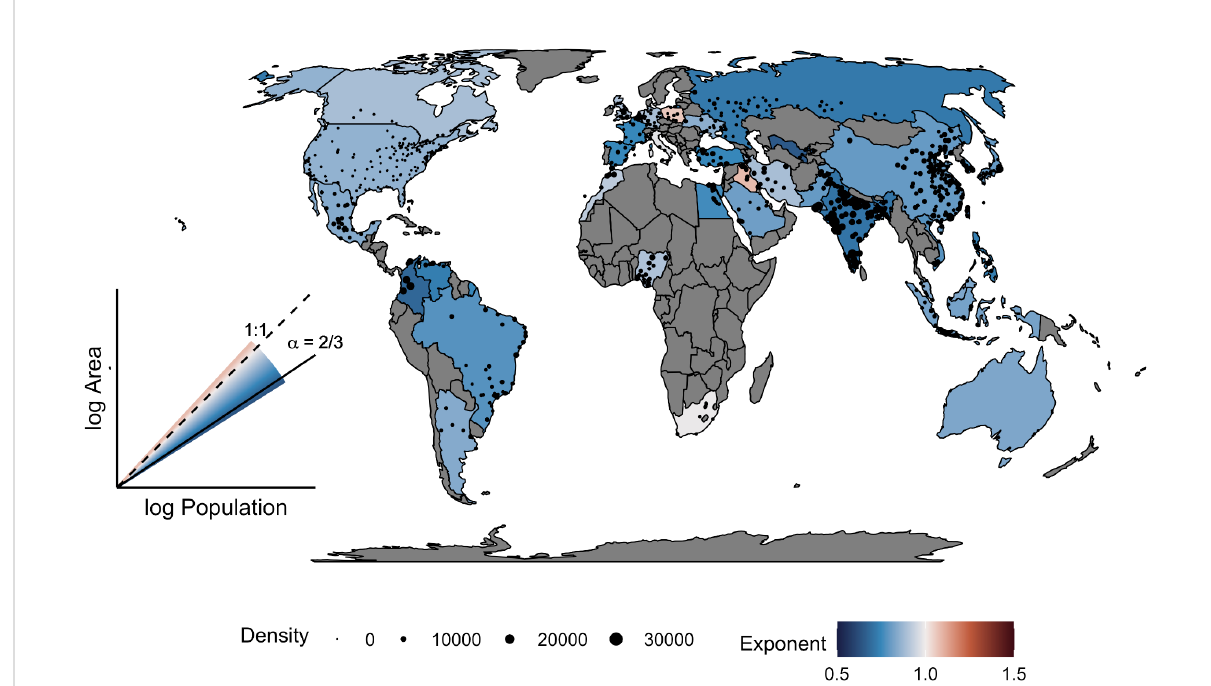
FIGURE 1 Global map of city scaling exponents for 38 countries for year 2015 from the GHS. See Appendix 1 for scaling statistics by country. Note that colors represent exponents for countries that contain more than 5 cities with an area >100km 2 and >50,000 population. Gray countries do not satisfy these criteria; point size represents city density, which varies from <1,000 to